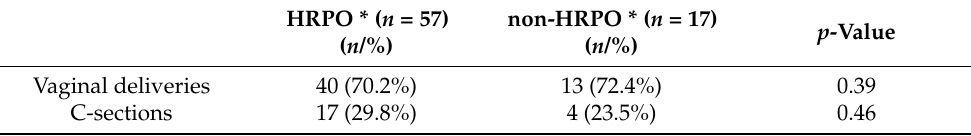
Table 3. Distribution of the mode of delivery regarding studied groups.